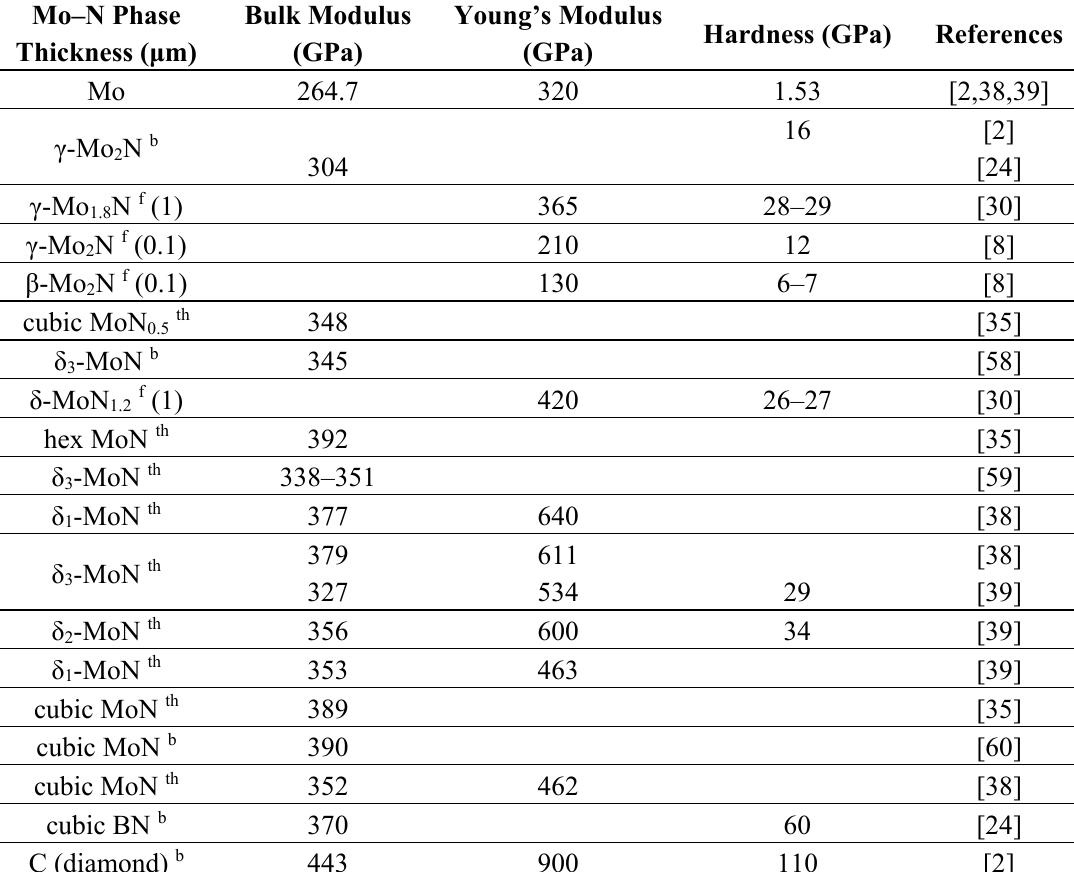
Table 3. Bulk modulus, Young’s modulus and hardness of Mo 2 N and MoN films ( f ) compared with bulk values ( b ), and theoretical values ( th ). The thickness (if known) is indicated in brackets. The values for Mo, cBN and C (diamond) are also